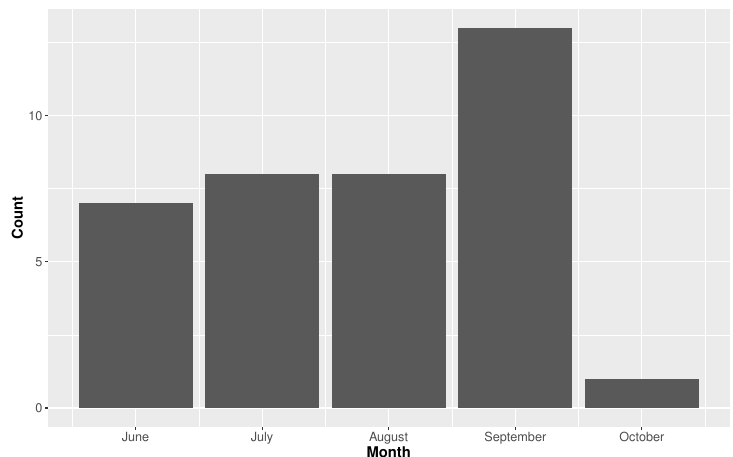
Figure 7. Monthly distribution for tropical cyclone (TC) rainfall in Houston, Texas showcasing the seasonality of TC rainfall.